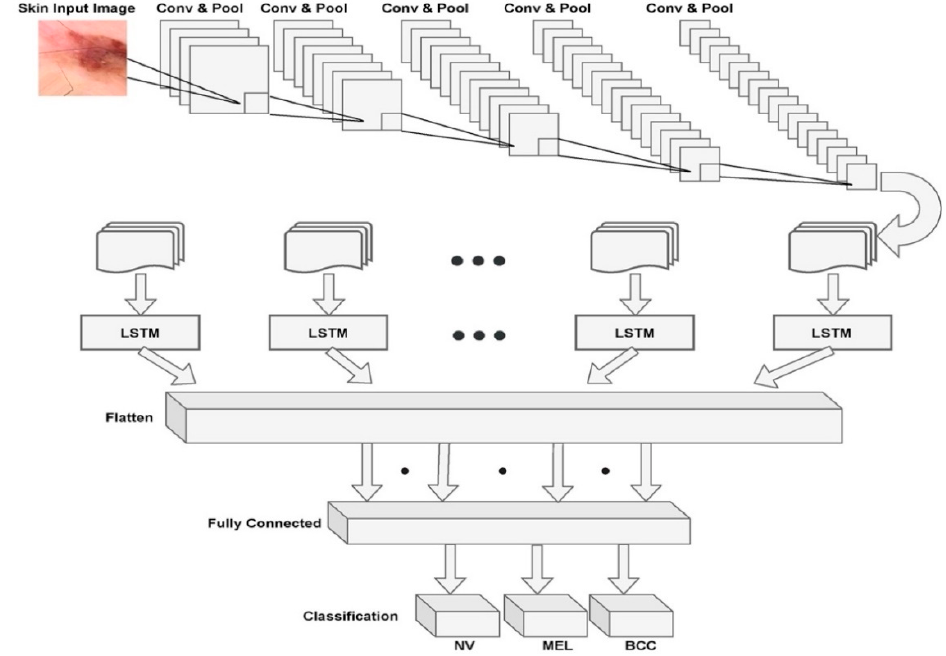
Figure 3. Architecture of the proposed model with MobileNet V2 and LSTM.